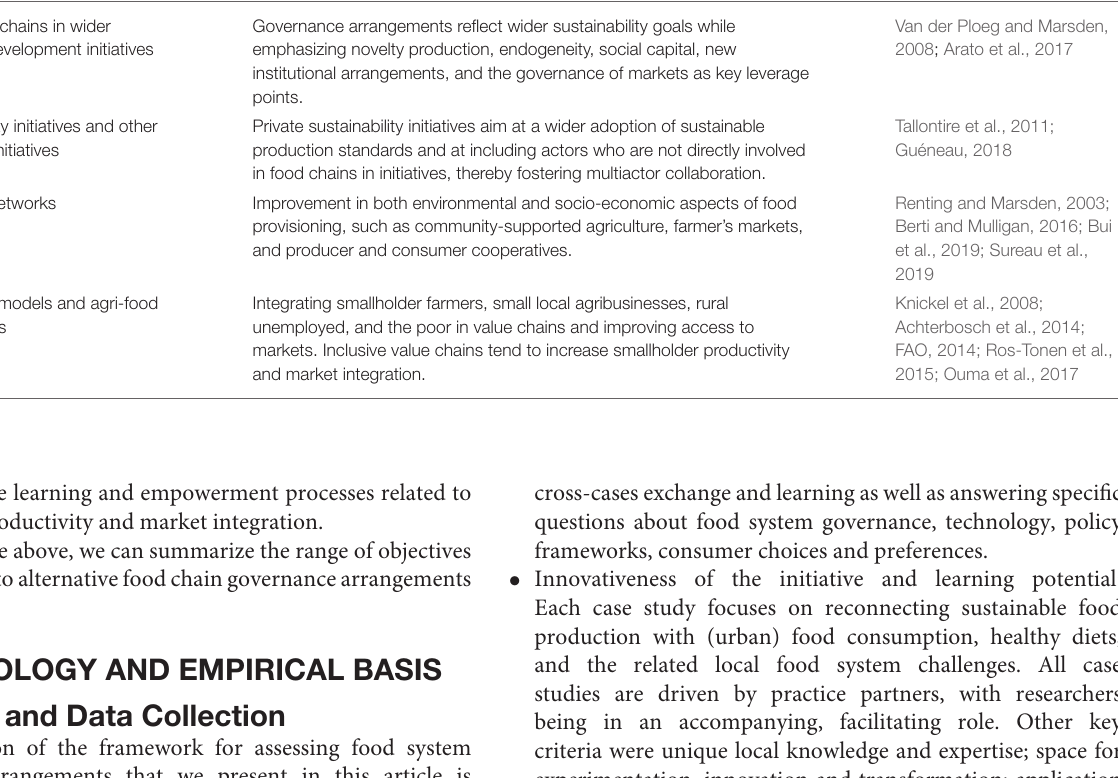
TABLE 1 | Agri-food chain governance arrangements that aim at meeting multiple objectives. Agri-food chain